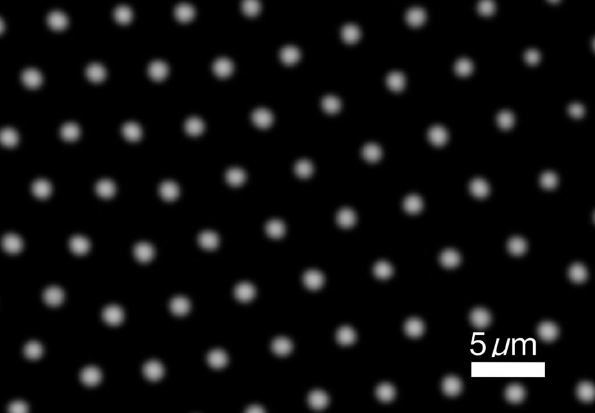
FIG. 8. PMMA particles at an oil-water interface. In the absence of a spatially varying potential, isotropically repulsive particles form a triangular